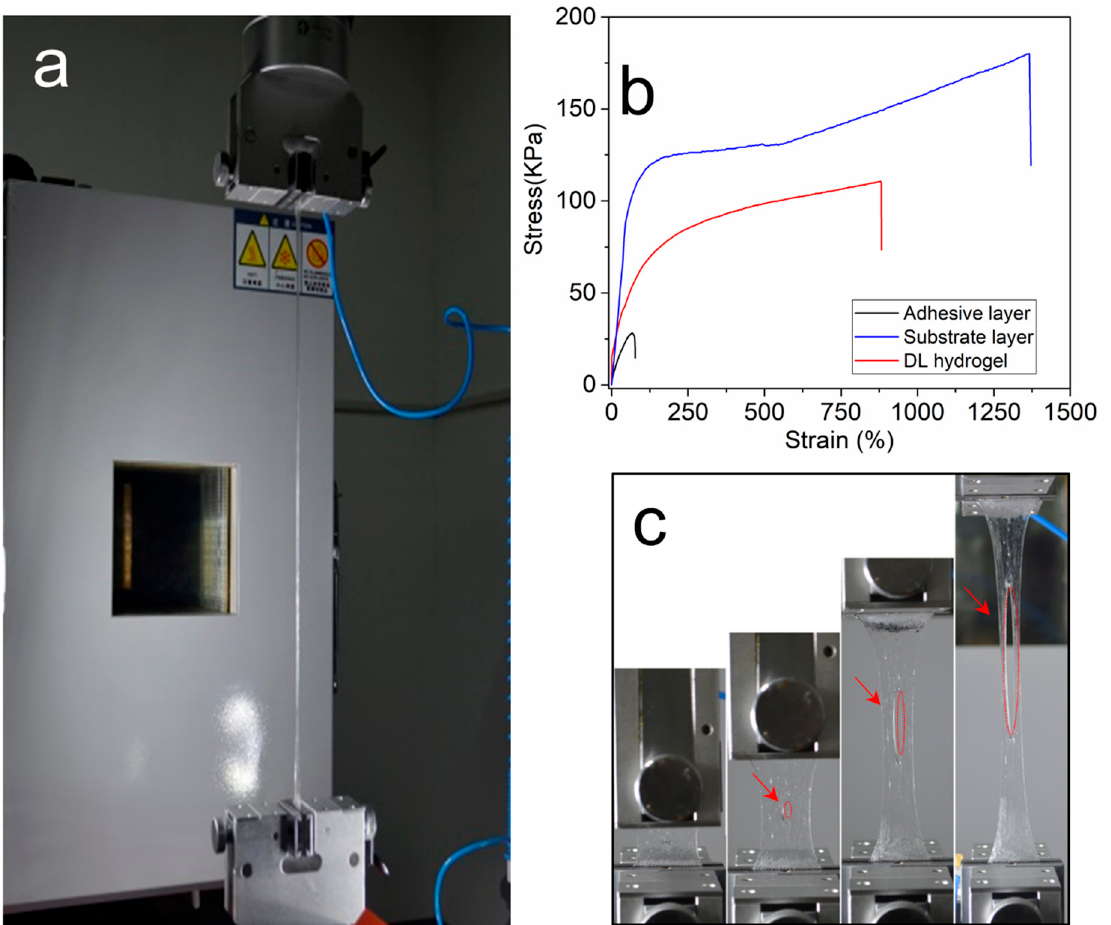
Figure 2. Mechanical properties of the hydrogels. ( a ) Photographs of a hydrogel under tensile test (v = 25 mm/min). ( b ) Tensile stress–strain curves of the AEtMA-Cl layer, substrate layer, and DL hydrogel as prepared. ( c ) Photographs of the hydrogel during a notch tensile test (v = 25 mm/min).